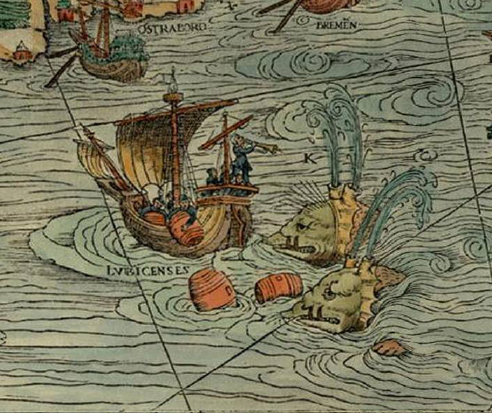
Figure 3. Carta Marina 1539 by Olao Magno (1490–1557), particular.